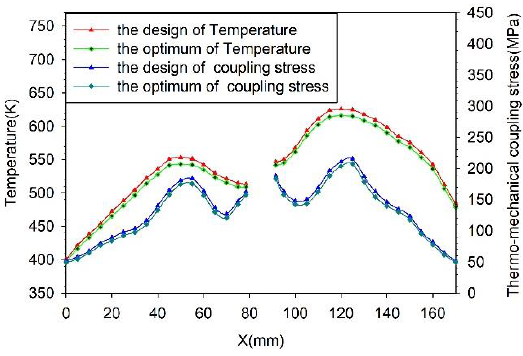
Figure 18. Comparison of thermo-structure coupling load in the radial direction X of the cylindrical head.